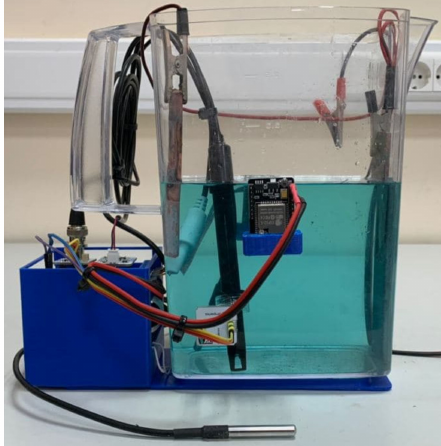
Figure 10. Photo of the developed system.